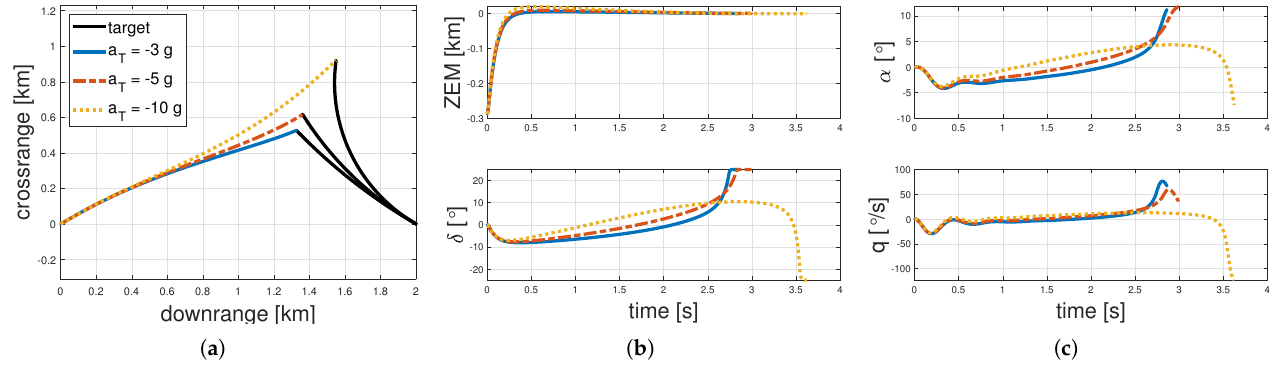
Figure 4. Simulation results of the integrated method under the canard-controlled missile model. ( a ) Flight trajectories. ( b ) ZEM and fin deflections. ( c ) State